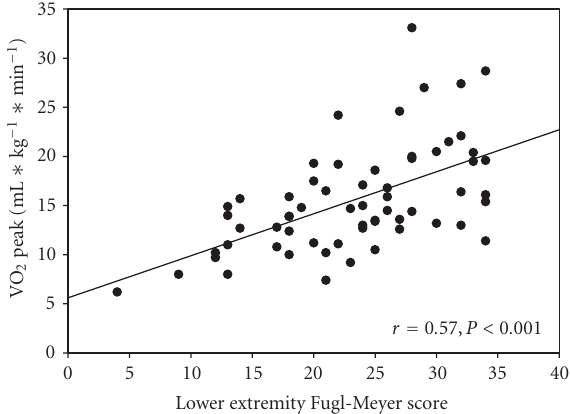
Figure 2: Scatterplot with a regression line overlay to demonstrate the relationship between VO 2 peak and lower extremity function using the